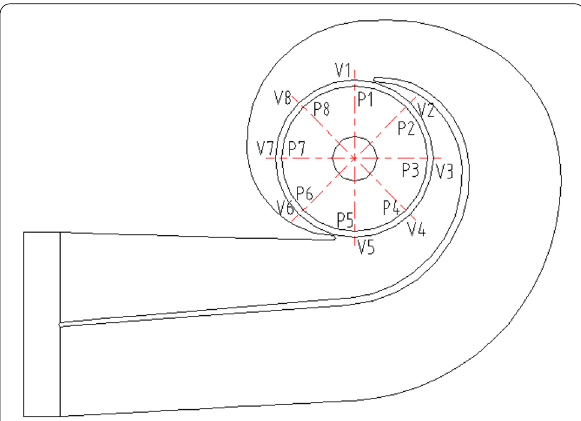
Figure 8 Locations of monitoring points in the impeller and